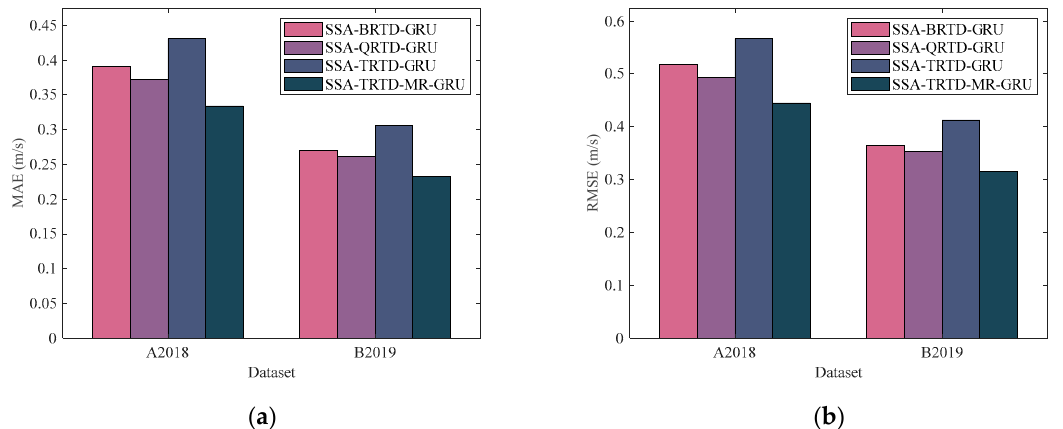
Figure 11. The comparison between the models with different schemes of real-time decomposition: ( a ) MAE; ( b ) RMSE.